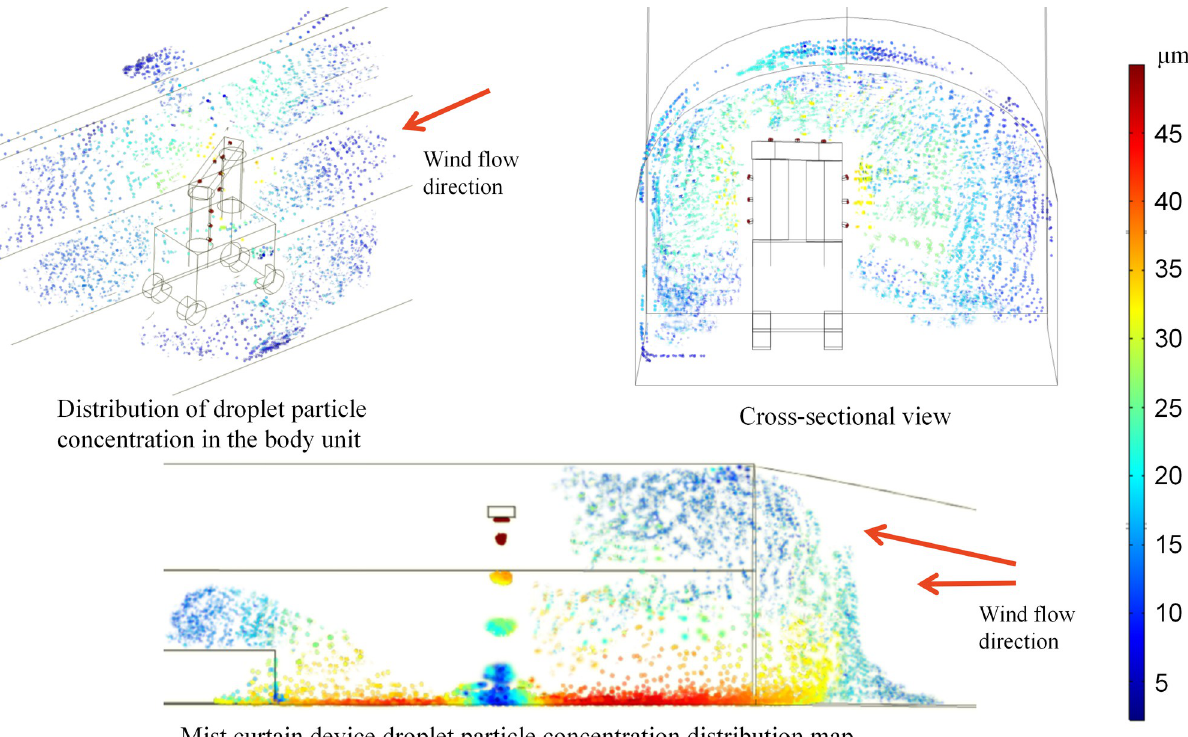
Fig 12. Droplet size distribution